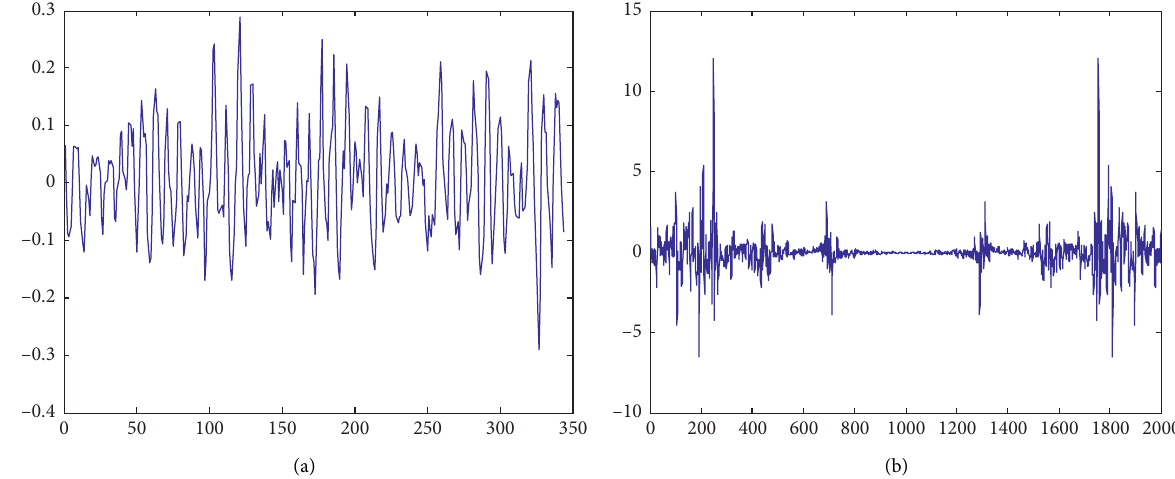
Figure 9: Partial time-domain data (a) and spectrum analysis (b) of fault 1.